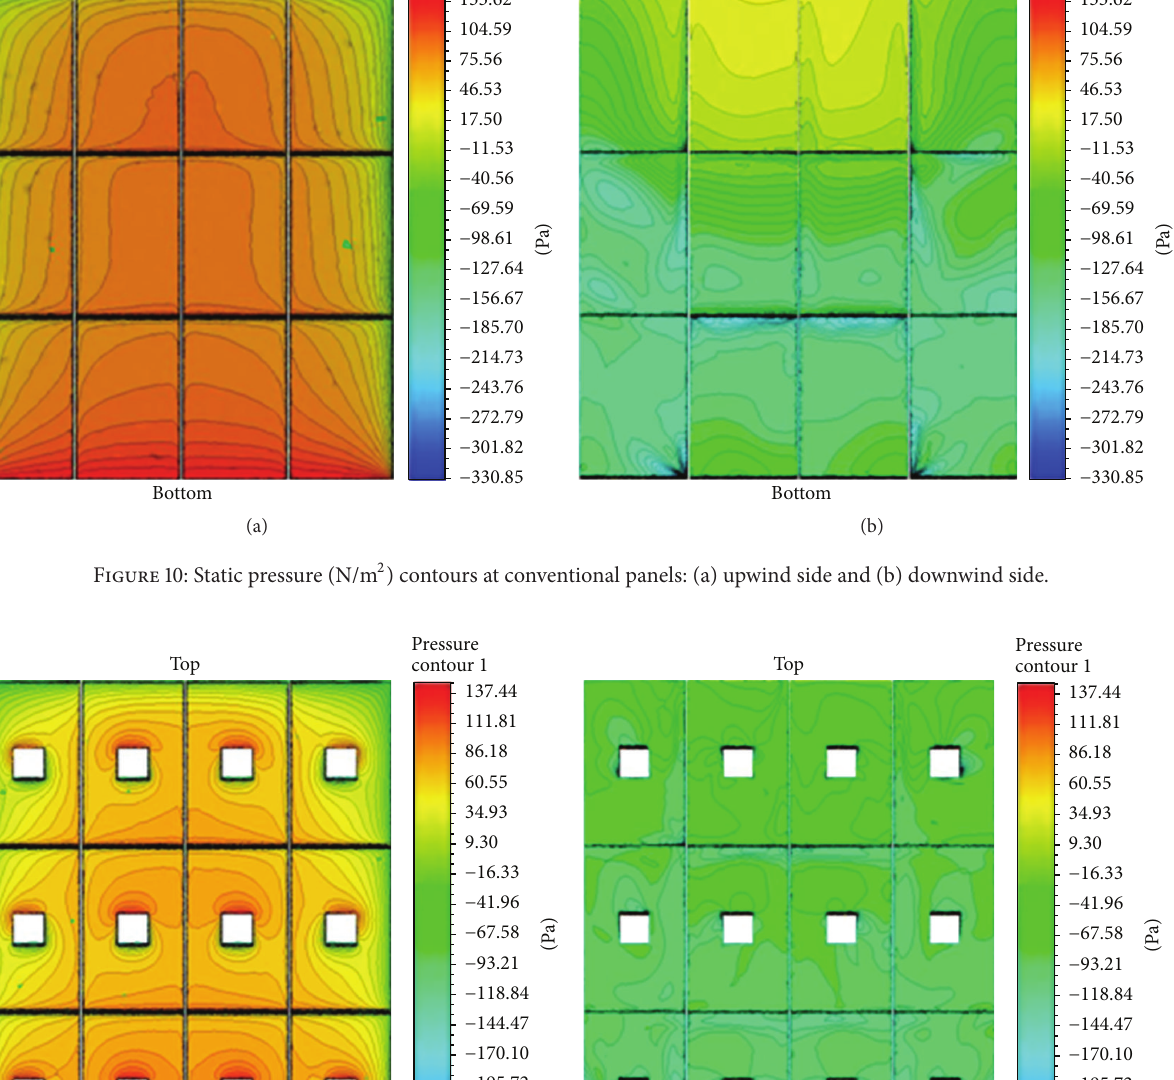
percentage load reduction is higher at 120.0 ∘ . The maximum load reduction occurs at 6.0 m/s upwind velocity and 120.0 ∘ approach